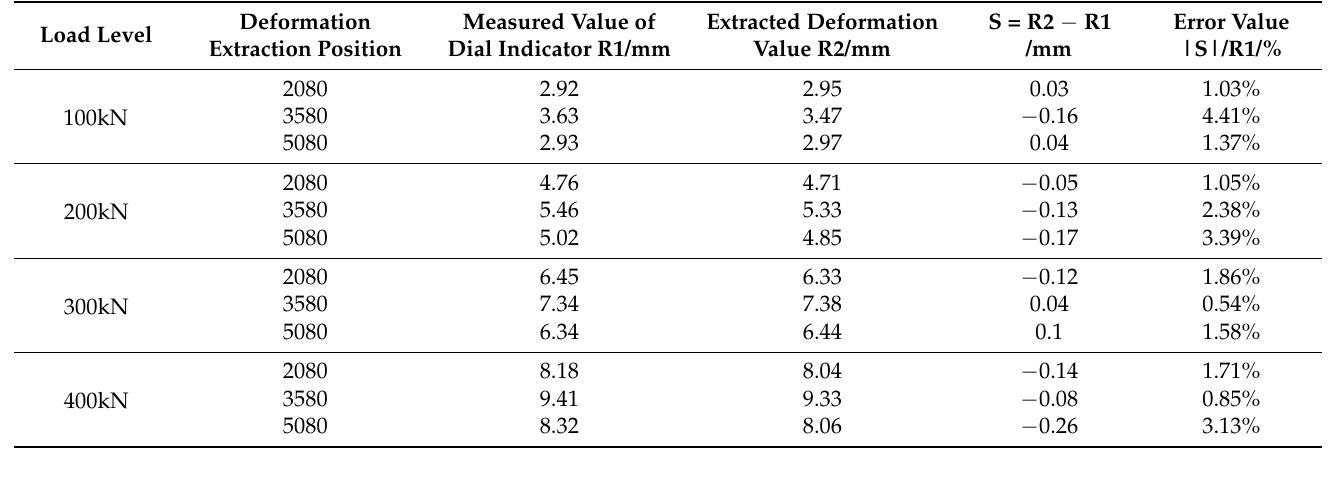
Table 3. Accuracy validation of deformation measurement.